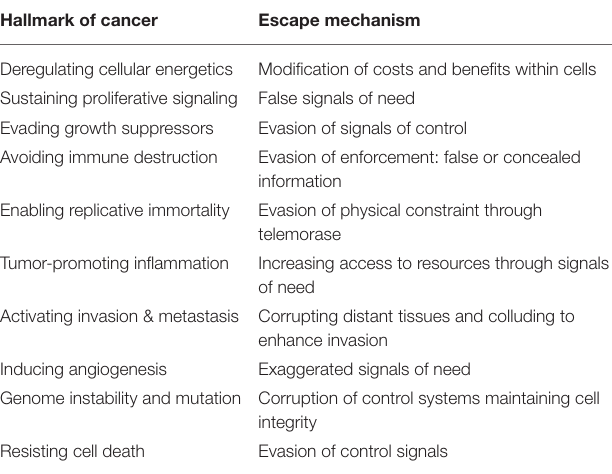
TABLE 4 | Hallmarks of cancer and escape mechanisms viewed through the lens of corruption. Hallmark of cancer Escape mechanism Deregulating cellular